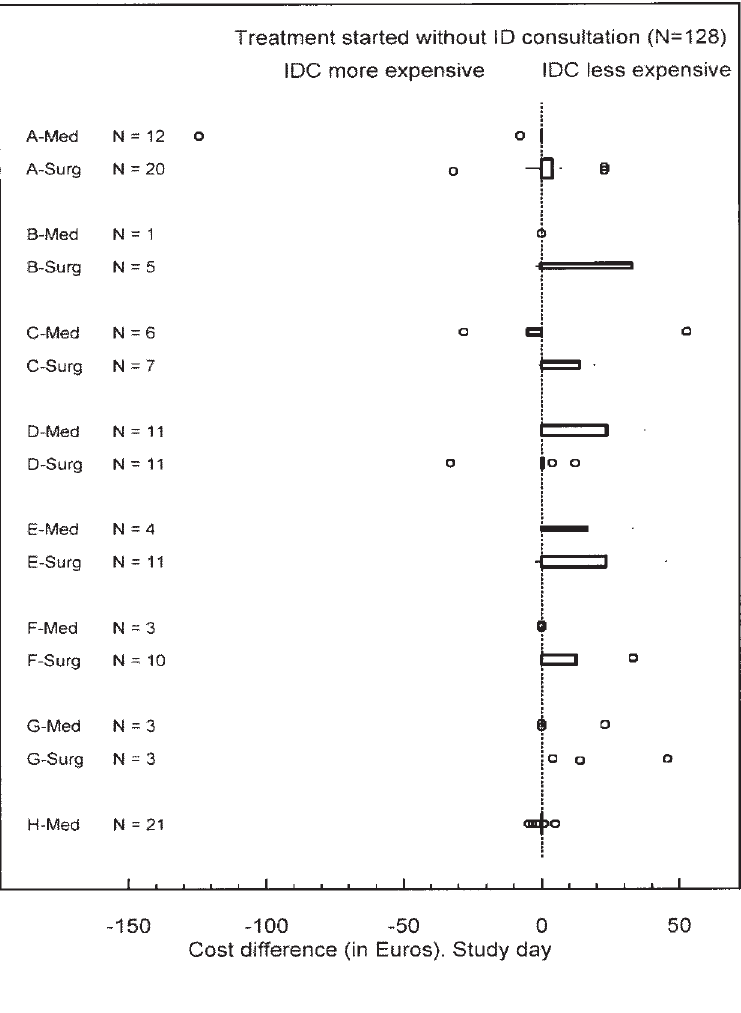
Box-plot of the differences in the cost of antibiotics prescribed by internists and surgeons and those proposed by infectious disease consultants (IDC), by hospital and by ward (study day), for patients treated without ID consultation (n =